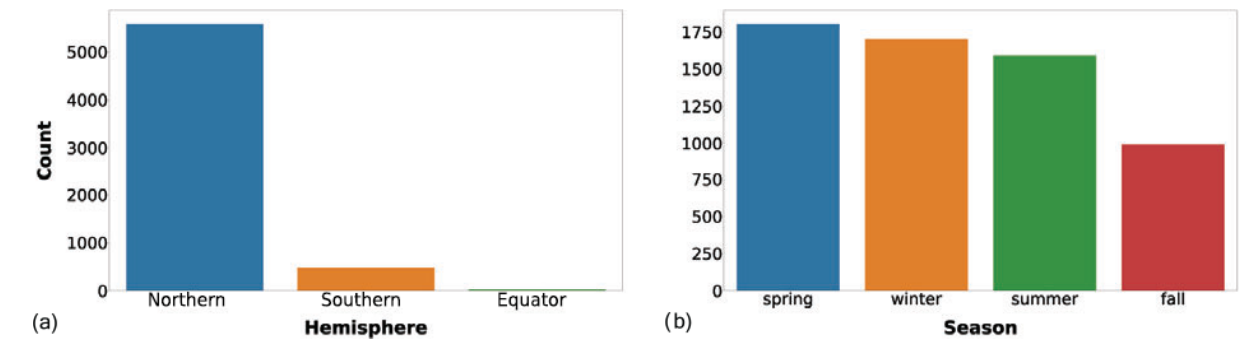
Figure 2. (a) Number of profiles gathered in the two hemispheres or at the Equator (5578, 478 and 28 respectively). (b) Number of profiles sampled in Northern Hemisphere winter (January to March), spring (April to June), summer (July to September) and fall (October to December).